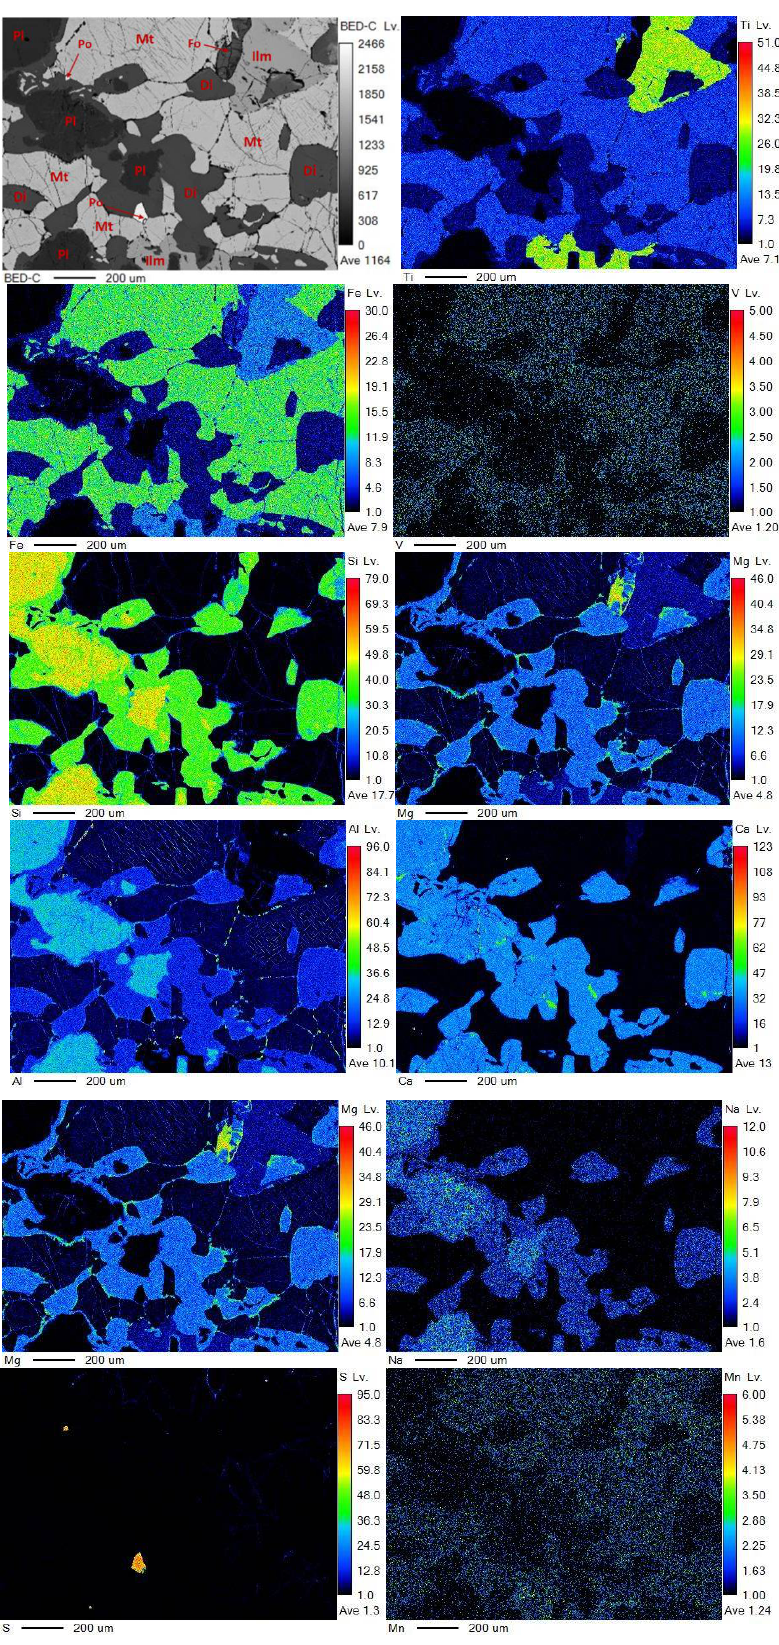
Figure 9. Distribution of the main elements in the gangue and sulfide minerals.